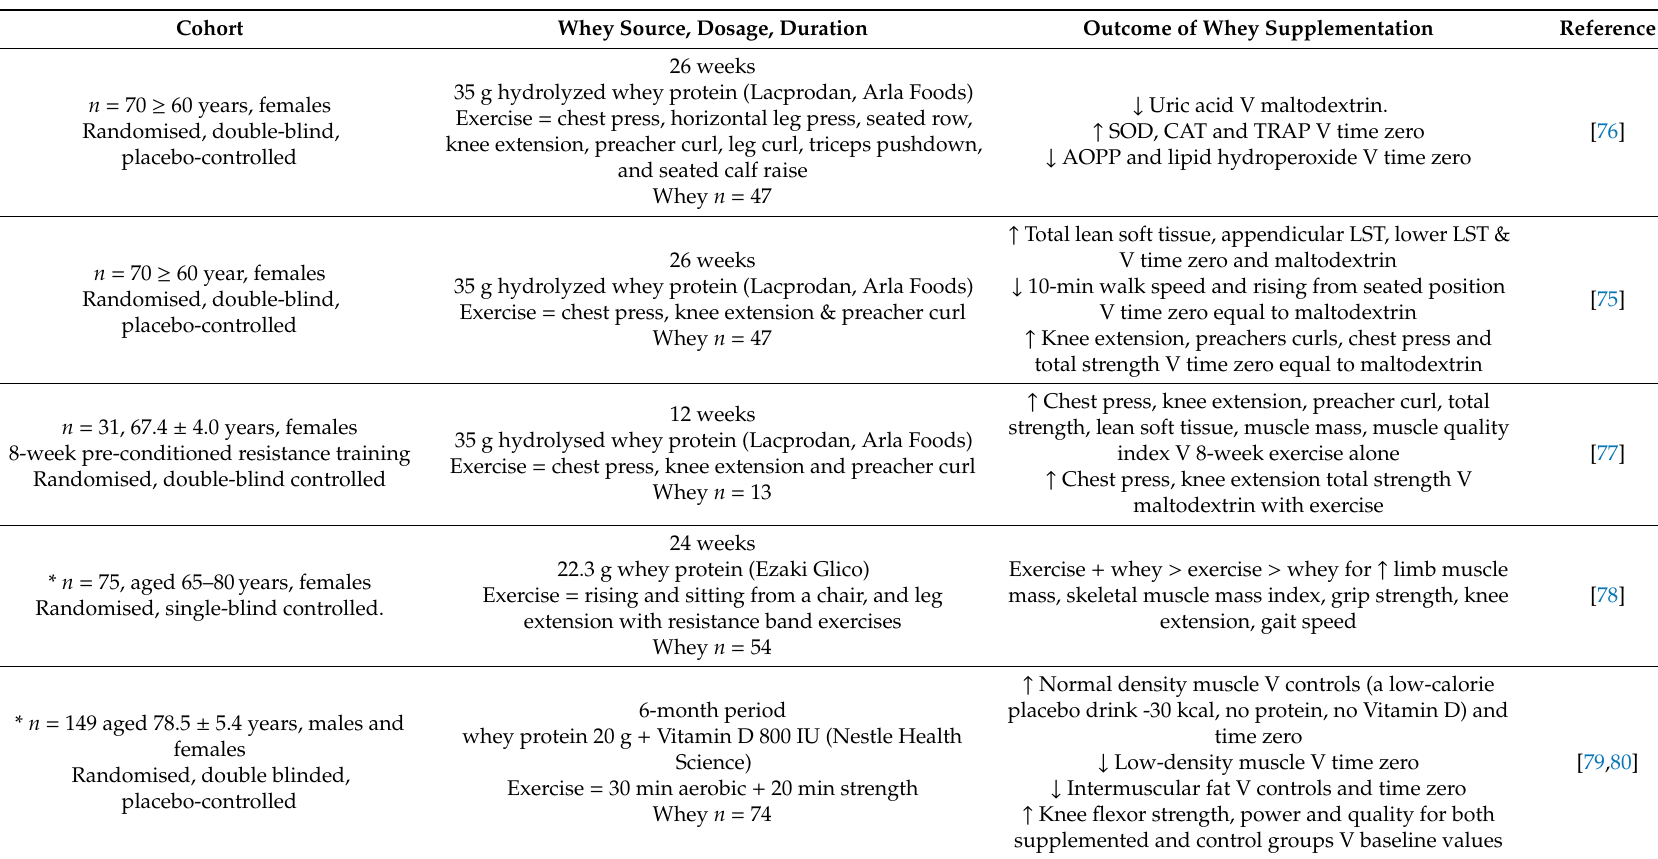
Table 4. Whey and exercise intervention trials with the older adult. SOD: superoxide dismutase; CAT: catalase; TRAP: total radical-trapping antioxidant parameter; AOPP: advanced oxidation protein products; LST: lean soft tissue; CSA: cross-sectional area; IL-6: interleukin 6; WPS: whey protein supplementation; SPPB: Short Physical Performance Battery; FRAP: ferric reducing antioxidant power; GSH: glutathione; * power calculation to determine number of subjects was